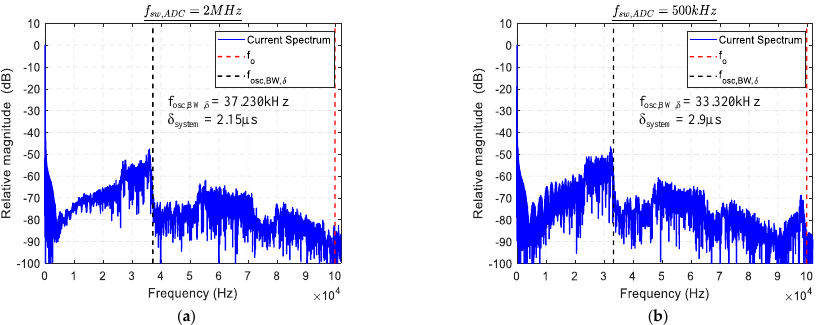
sw , ADC of ( a ) 2 MHz